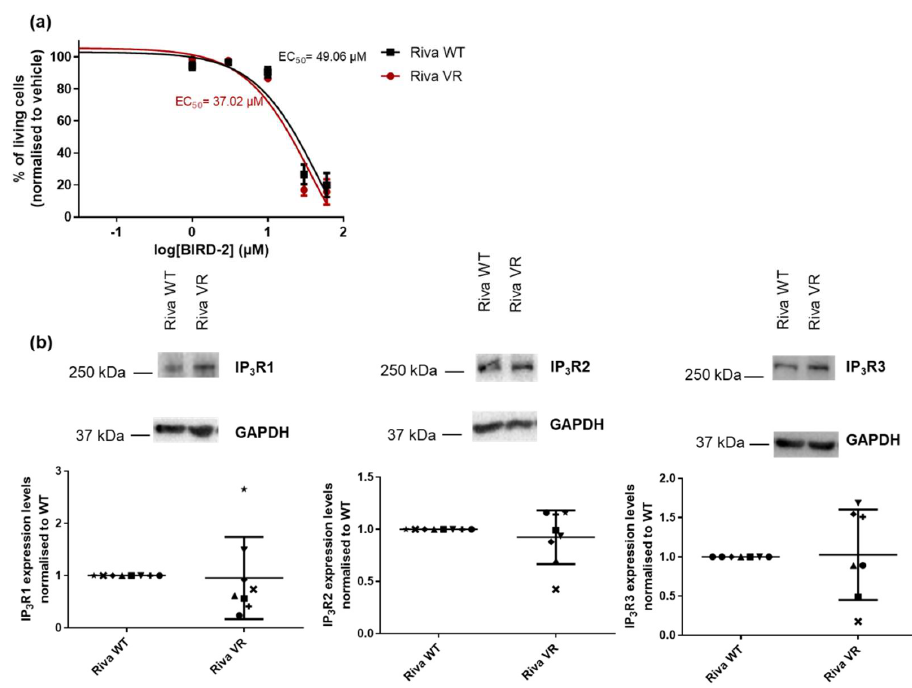
Figure 2. Riva WT and VR cells have a similar sensitivity towards BIRD-2 treatment. ( a ) Dose–response curves of Riva WT and VR cells after incubation with BIRD-2 for 24 h. The apoptotic population was defined as the AnnexinV-FITC-positive fraction. Data presented are average ± SEM ( n = 5). ( b ) Representative Western blots of IP 3 R1, 2 and 3-expression levels in Riva WT and Riva VR cells. GAPDH was used as a loading control. Quantification of IP 3 R1, -2 and -3-protein levels in Riva WT and Riva VR cells. For each blot, the immunoreactive bands were quantified and normalized towards the signal obtained for Riva WT cells, which was set at 1. Data are presented as average ± SD ( n ≥ 7).